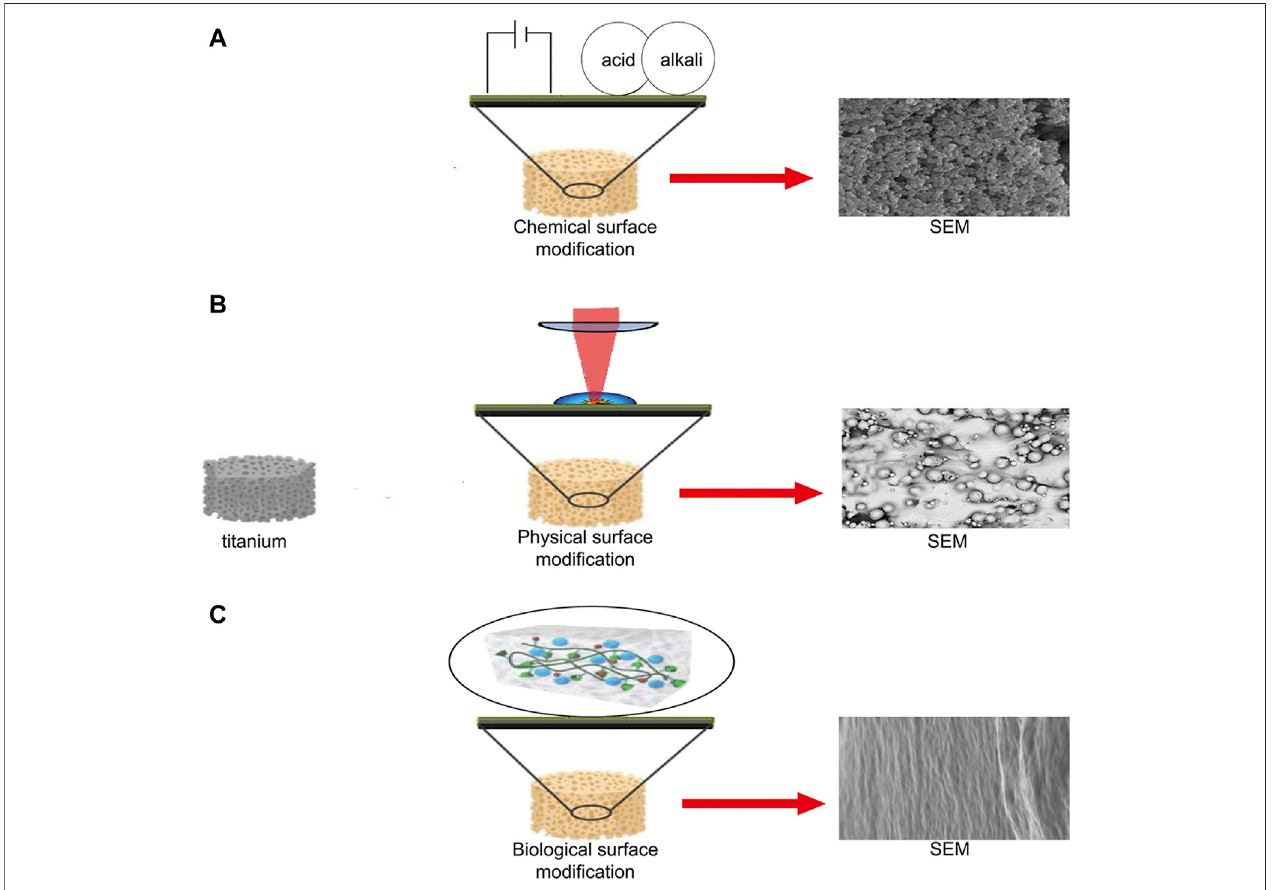
FIGURE 2 | Schematic diagram of chemical, physical, and biological surface modi fi cation technologies. (A) Implant surface microstructure produced by electrophoretic deposition (Surmeneva et al., 2019). (B) Microstructure of implant surface produced by laser peening (Soyama and Takeo, 2020). (C) Surface microstructures of implants produced by hydrogel packaging (Mieszkowska et al., 2020).